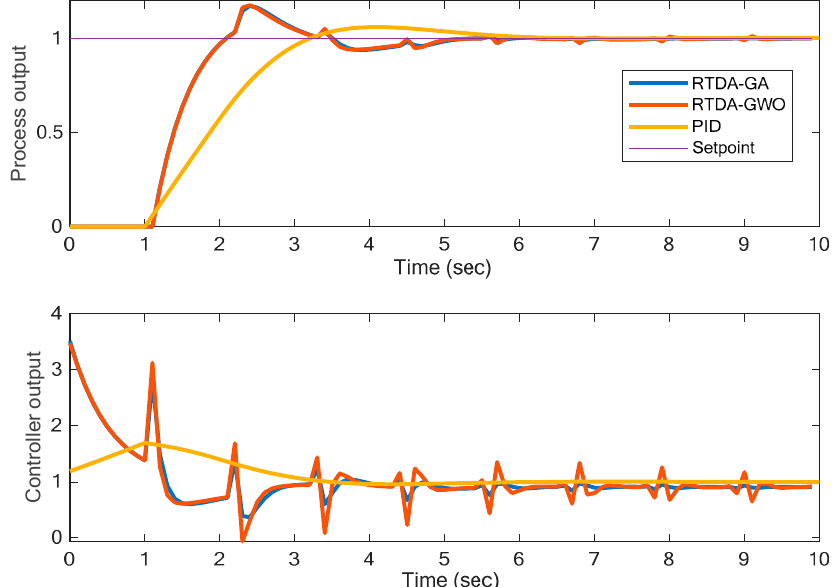
Figure 8. Closed loop response with RTD-A and proportional integral derivative (PID) for the first-order process with dead time (FOPDT) process. Table 7. Performance comparison of RTD-A and PID for the FOPDT model.